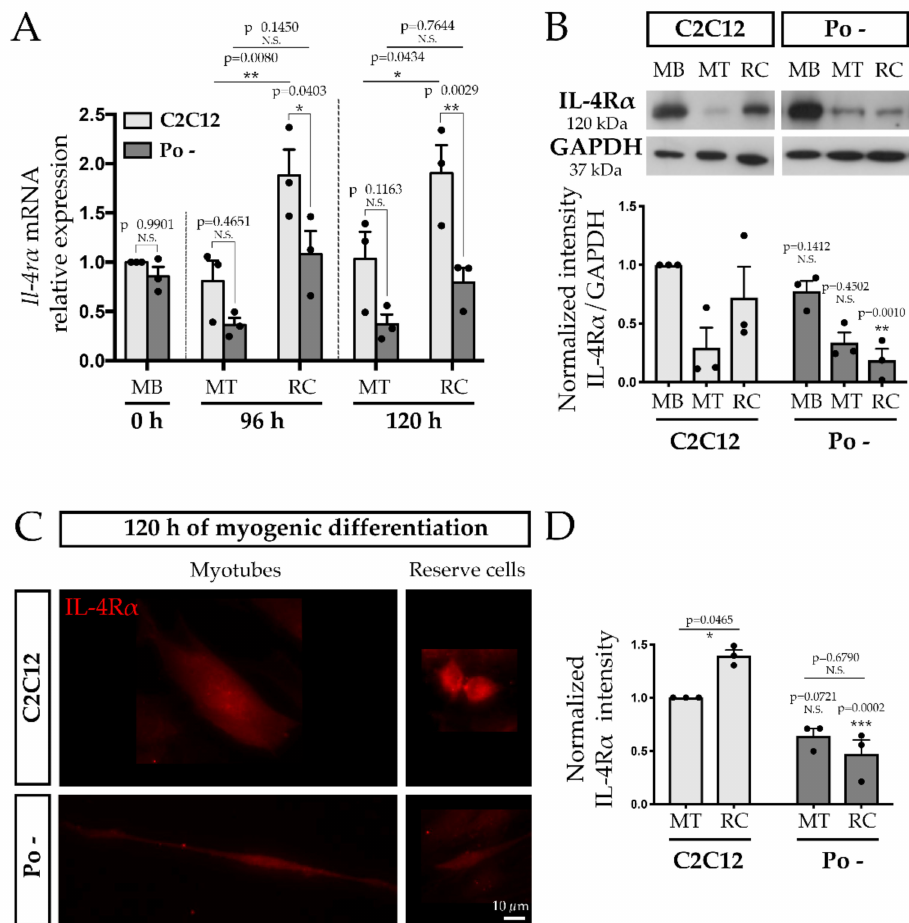
Figure 5. IL-4R α expression for reserve cells decreases in Po – cells during di ff erentiation time course compared to WT C2C12. qPCR analysis ( A ) performed on both cell lines highlighted that Il-4r α mRNA quantity is significantly decreased in Po – RC at 120 h, which is confirmed in terms of proteins by Western blot (WB) ( B ), immunofluorescence labelling ( C ) and its quantification ( D ). qPCR, WB and immunofluorescence experiments were done in biological triplicates and fold changes calculated relative to WT C2C12 cells, MB for qPCR and WB, and MT at 120 h for immunofluorescence quantification. Bar graphs represented means ± SEM. In ( A ), each mean of replicates was symbolized by a dark dot. Statistical analyses were performed using a two-way ANOVA with p-value calculated by Sidak’s post-, which compared within di ff erentiation times and according to both cell types, MT and RC. * p < 0.05; ** p < 0.01; *** p < 0.001. N.S., not